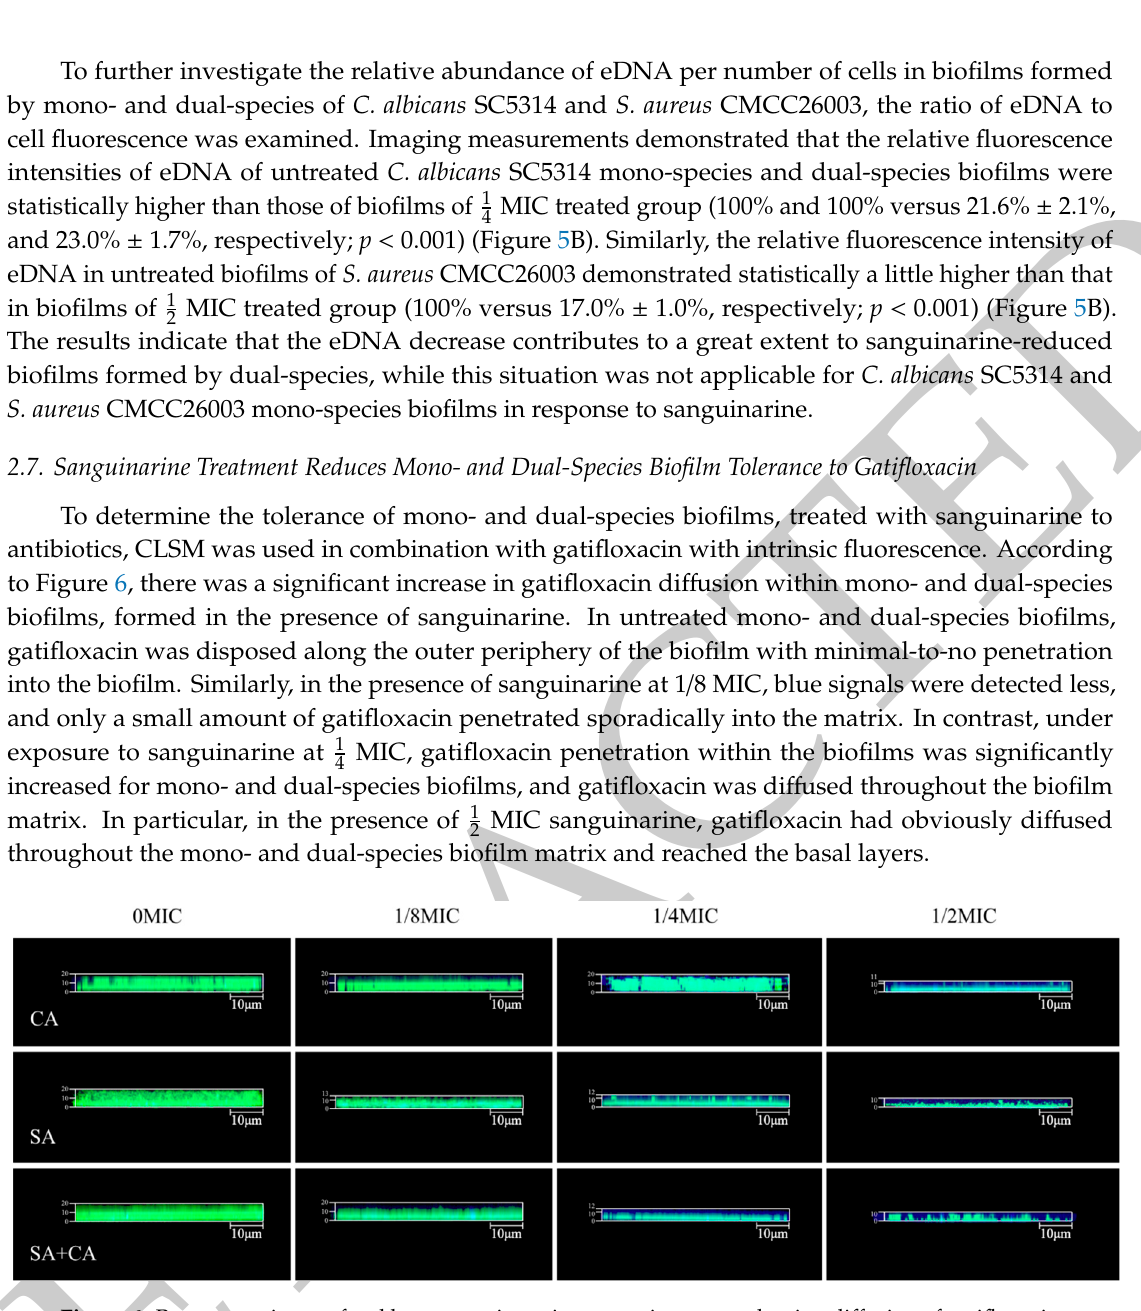
Figure 6. Representative confocal laser scanning microscopy images evaluating diffusion of gatifloxacin within C. albicans SC5314 (CA) and S. aureus CMCC26003 (SA) mono- and dual-species (SA+CA) biofilms formed in the presence of sub-MIC sanguinarine. Biofilms were stained with SYTO 9 for biofilms (green) and the intrinsic fluorescence of gatifloxacin (blue). Scale bars represent 10 μ m.